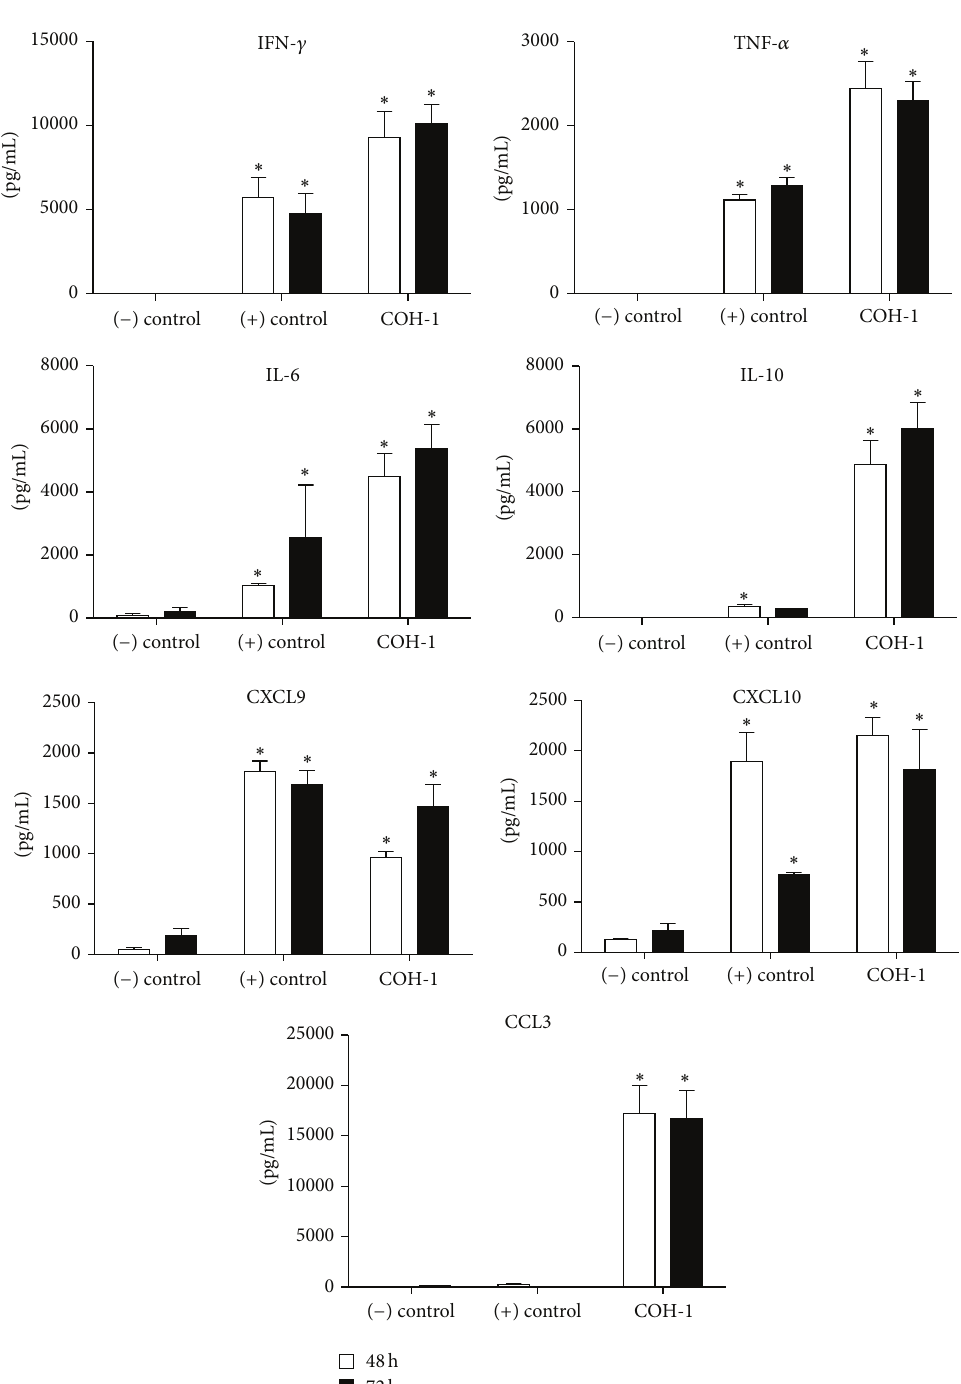
Figure 2: Ex vivo cytokine and chemokine production profile by total splenocytes. C57BL/6 mice were injected intraperitoneally with a dose of 10 7 CFU of wild-type GBS serotype III strain COH-1 ( 𝑛 = 3 per group × 3 individual experimental infections). Spleens were harvested 6h after infection and total splenocytes plated at 5 × 10 6 cells/well. After 4 h of incubation, the bacteriostatic agent chloramphenicol (12 𝜇 g/mL) was added to the culture to prevent cell toxicity. Cells were then incubated for 48 h and 72 h and supernatants were collected for cytokine analysis by ELISA. Nonstimulated cells from mock-infected animals served as negative ( − ) control for basal expression. Cells stimulated with Concanavalin A (0.1 𝜇 g/mL) were used as positive (+) control. Data are expressed as means ± SEM (in pg/mL) from 3 different experimental infections. ∗ 𝑃 < 0.05 indicates statistically significant difference compared to ( − ) control